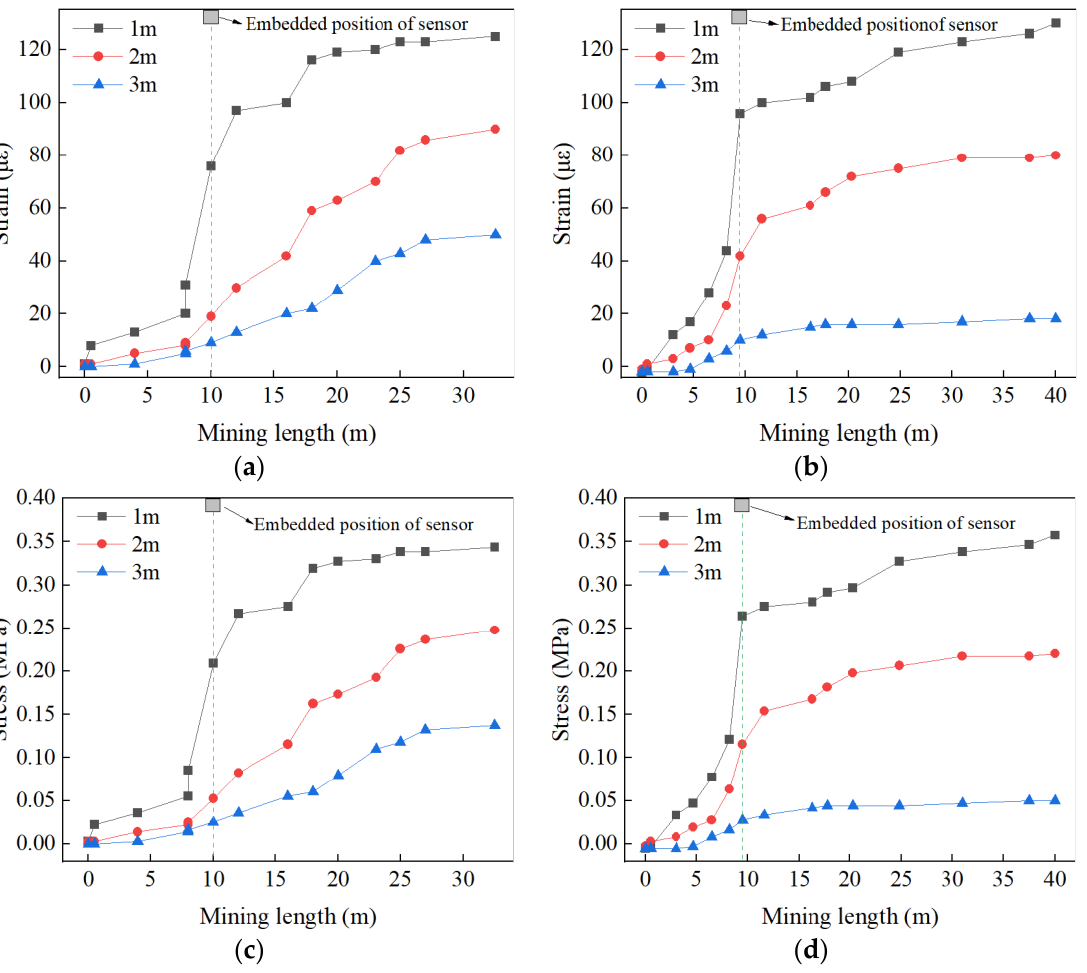
Figure 4. Results of stress – strain measurements: ( a , c ) are the strains and stresses in 48# stope, ( b , d ) are the strains and stresses in 40# stope, respectively.